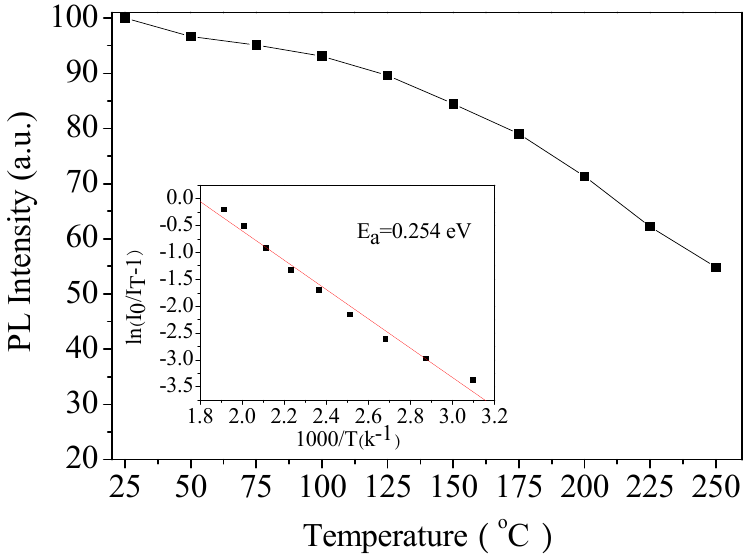
Figure 10. Temperature dependence of the PL intensity of LL 0.83 M:0.05Sm 3+ ,0.12Eu 3+ phosphor. Inset shows the fitting of the emission intensity according to the Arrhenius equation and the calculated activation energy are indicated in the inset.